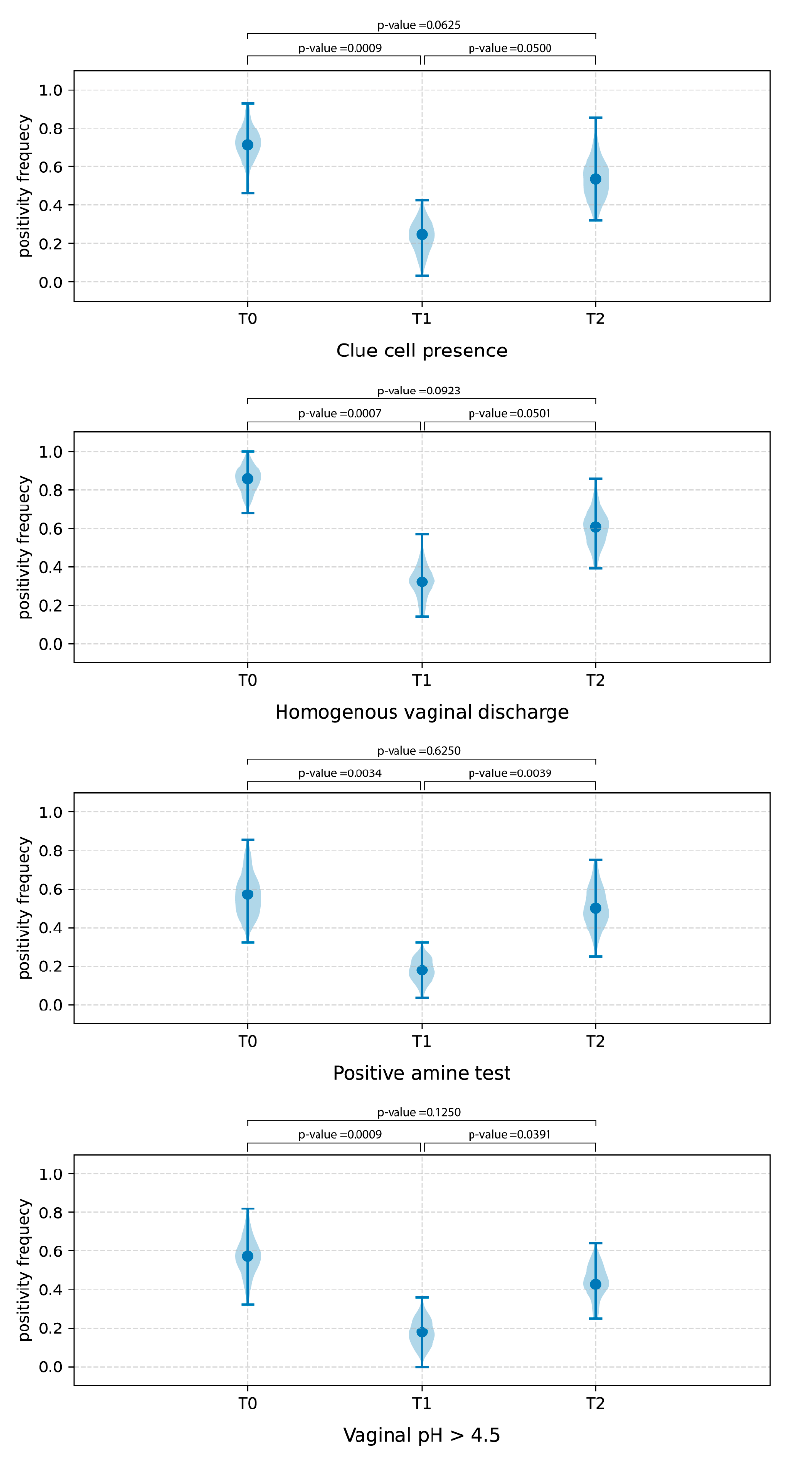
Figure 2. Frequency of positivity of Amsel criteria at T0 (baseline), T1 (15 days after the start of treatment (T1), and T2 (7 days after the end of treatment) sampling times.